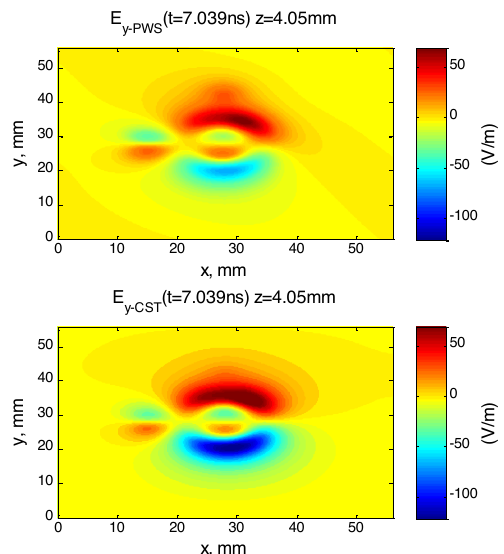
Figure 16: Comparison of E CST simulation and the proposed computation method.